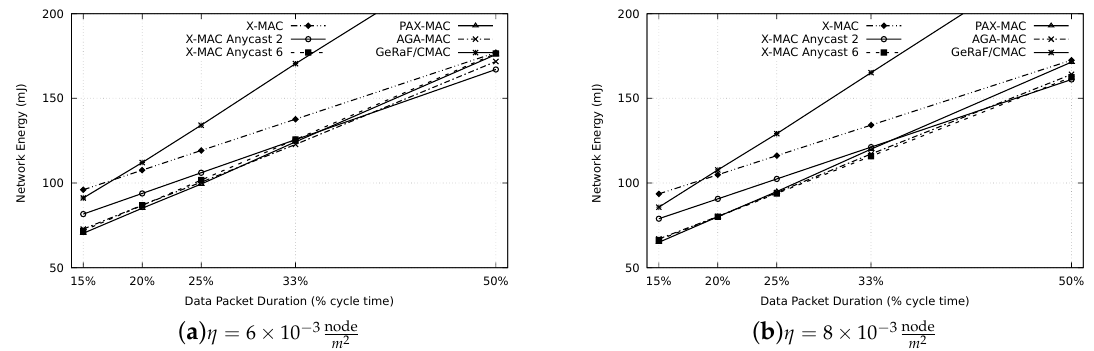
Figure 16. Energy consumption for the 6 different protocols, with the destination 650 m distant from the source. For all measurements, confidence interval shorter than ( x + 5, x − 5 )